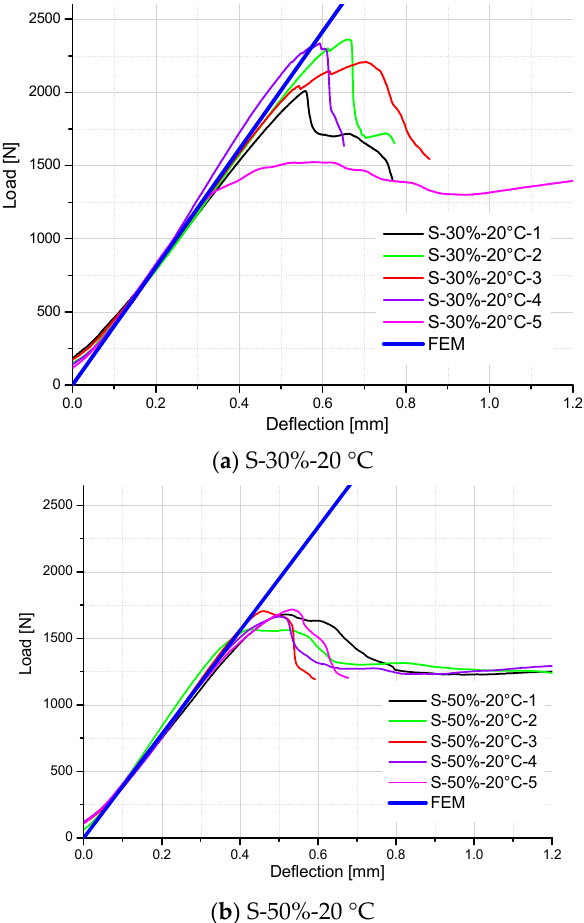
Figure 13. Comparison of load–deflection curves between FE analysis and test results of S-30%-20 °C specimens and S-50%-20 °C specimens.